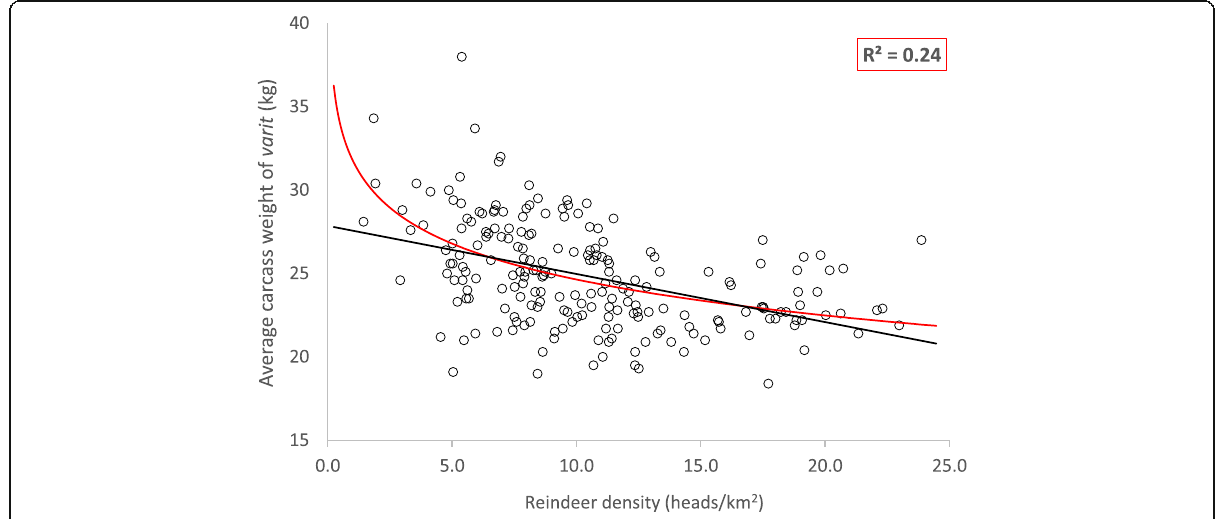
Fig. 5 Relationship between carcass weights of varit and herd density in mainland districts of Western Finnmark (data source: